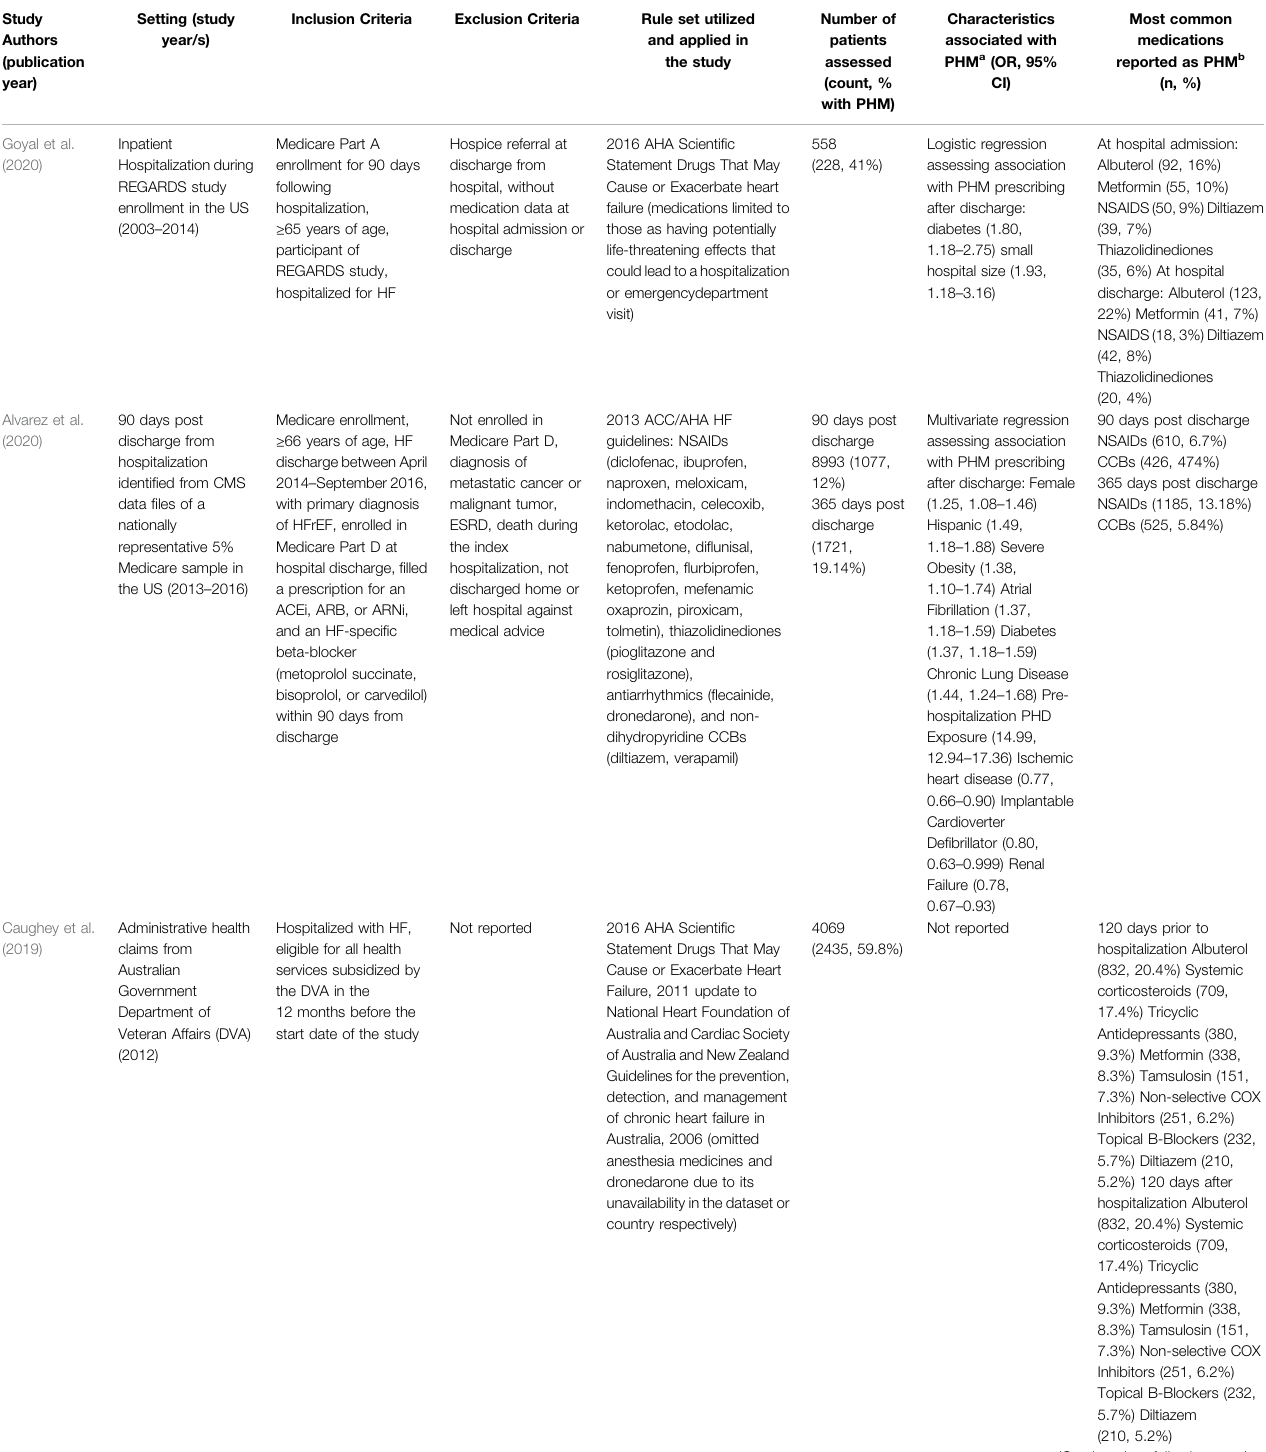
TABLE 1 | Summary of studies reporting potentially harmful medication prescribing in patients with heart